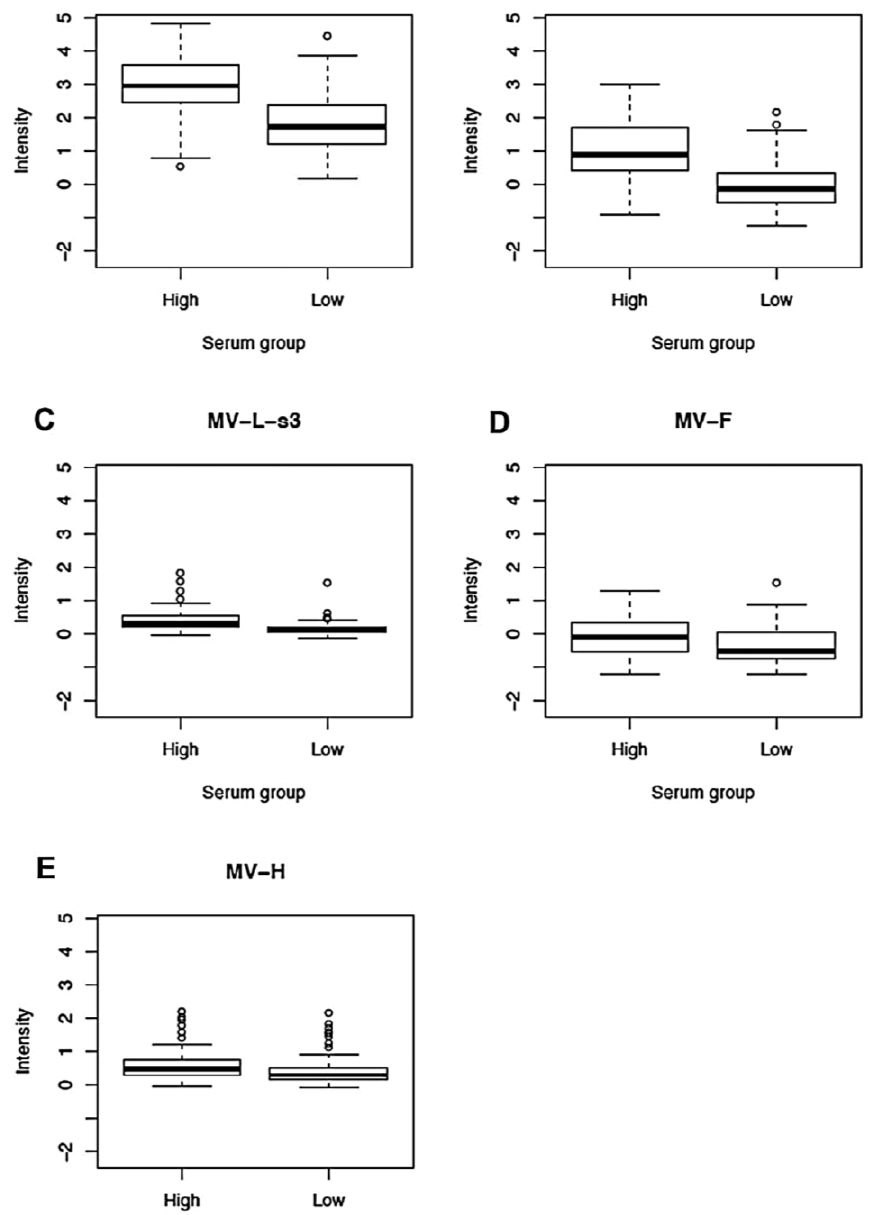
Figure 1. Normalized proteome microarray antibody reactivity against different measles virus proteins in 150 study subjects after two doses of MMR vaccine. ( A ); ( B ); ( C ); ( D ) and ( E ): Box-and-whisker plots of antibody reactivity, presented as log 2 normalized signal intensity value on the vertical axis, for P, N, L-s3, F and H protein, respectively, in the high and low immune response groups (selected based on neutralizing antibody titers). The top (bottom) of the box indicates the 75th (25th) percentiles, respectively, while the bold line within the box indicates the median. The “whiskers” extend up to 1.5 times the interquartile range above or below the 75th or 25th percentiles, respectively. Beyond that point, individual points are